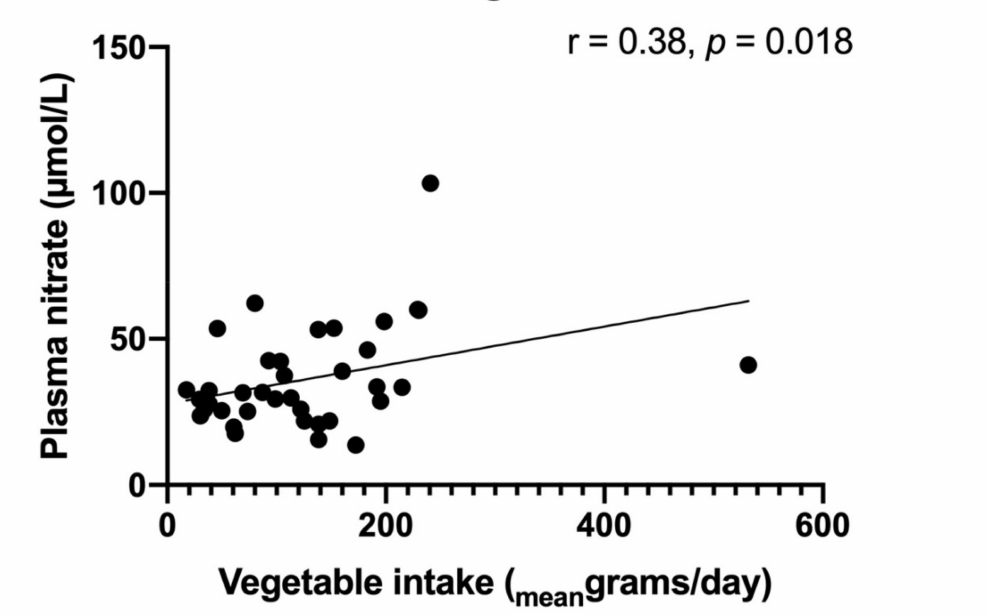
Figure 2. Food frequency questionnaire assessed vegetable intake was associated with plasma nitrate level. Correlation between mean daily vegetable intake (in mean grams/day) and plasma nitrate concentration (as measured by high-performance liquid chromatography and expressed in µ